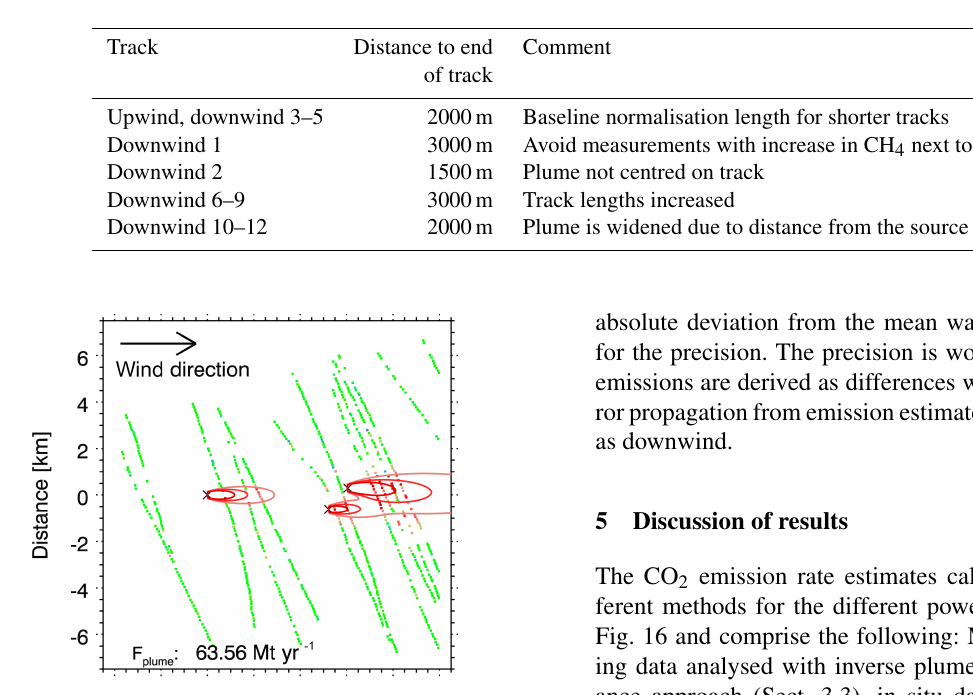
Table 4. Normalisation distances to the end of the measurement track for each individual remote sensing transect.